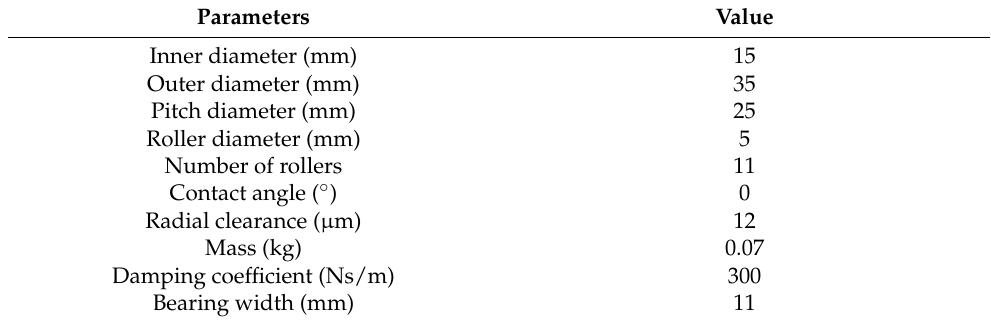
Table 1. NU202EM bearing parameters.